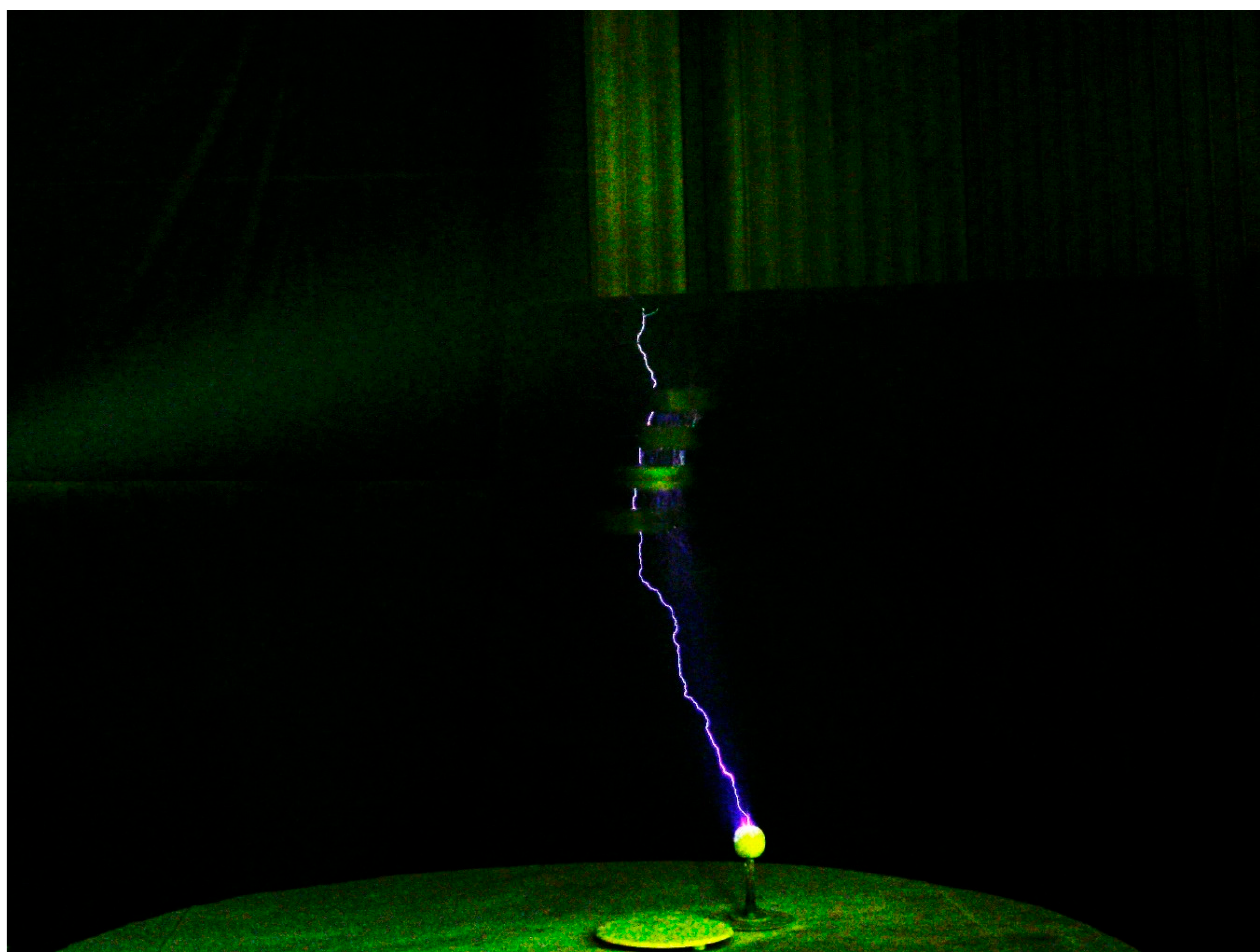
Figure 3. Discharge formation between a single positively charged thunderstorm cell and the ground involving one group of model hydrometeors.